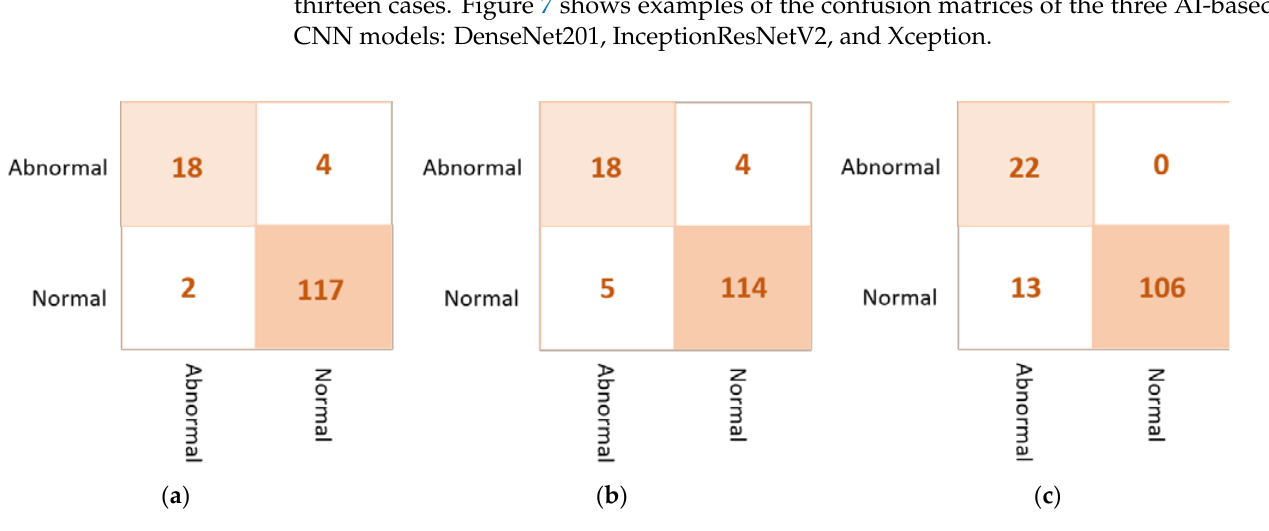
Figure 7. Example of the confusion matrices in the binary approach for individual pre-trained models using INbreast testing set : ( a ) DenseNet201, ( b ) InceptionResNetV2, and ( c ) Xception.